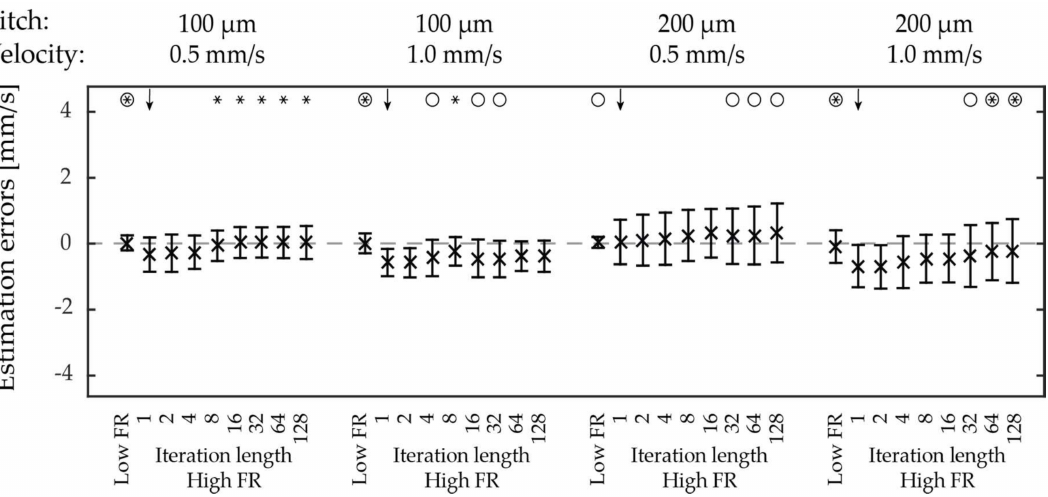
Figure 5. Axial estimation errors of the velocity for two different velocities each using two different pitches (100 µ m and 200 µ m). The crosses indicate the mean estimation with the error bars indicating ± one standard deviation. Significant changes ( p < 0.05) were calculated compared to k = 1 in each setting (marked with an arrow). The star indicates a change in mean estimation error and a circle indicates a change in the standard deviation. FR signifies frame rate: low = 41 Hz, high = 1302